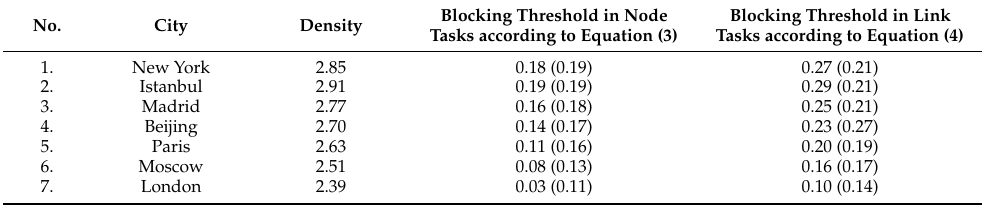
Table 3. Densities of transport bonds in any world cities and values of their blocking